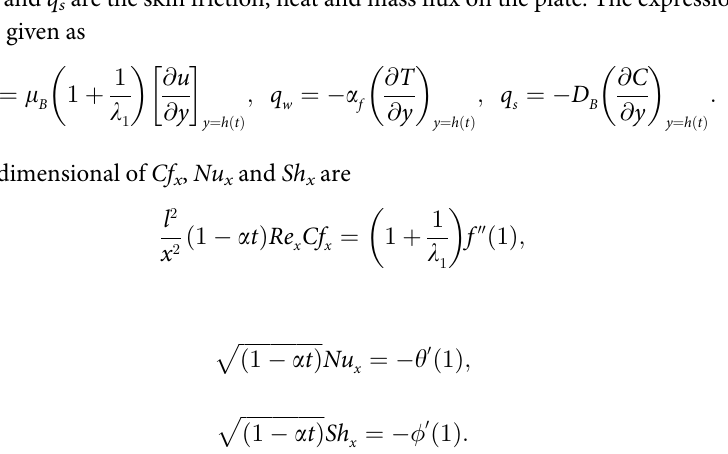
ffiffiffiffiffiffiffiffiffiffiffiffiffiffiffiffi p ð 1 (cid:0) a t Þ